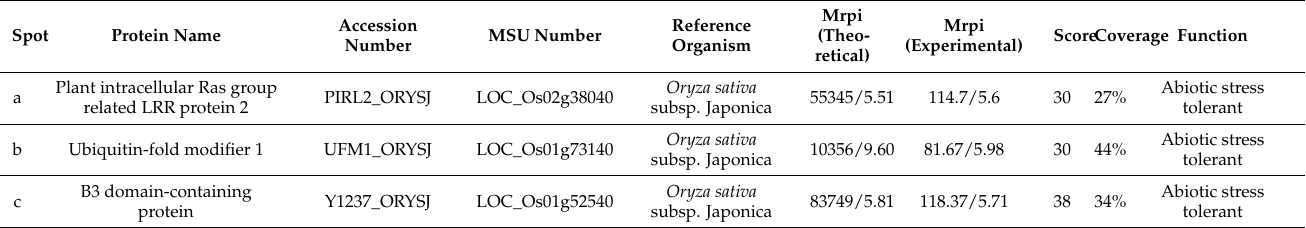
Table 2. Highly expressed proteins in Luna Suvarna (LS) roots as compared to IR64 identified using MALDI-ToF/ToF mass